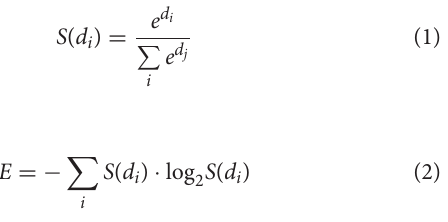
FIGURE 3 | Image example with high information quality.